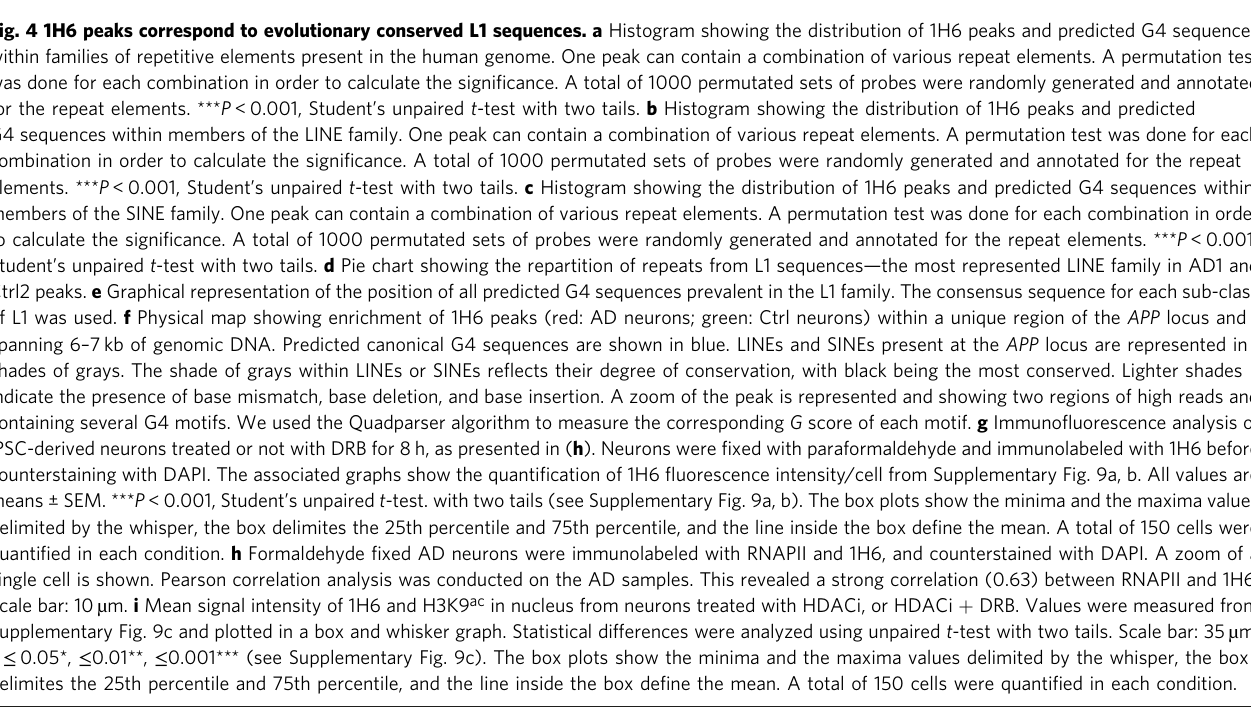
DNAH6 protein isoforms observed in AD neurons (Fig. 5d and Supplementary Fig. 12). Ef fi cient exon splicing can be